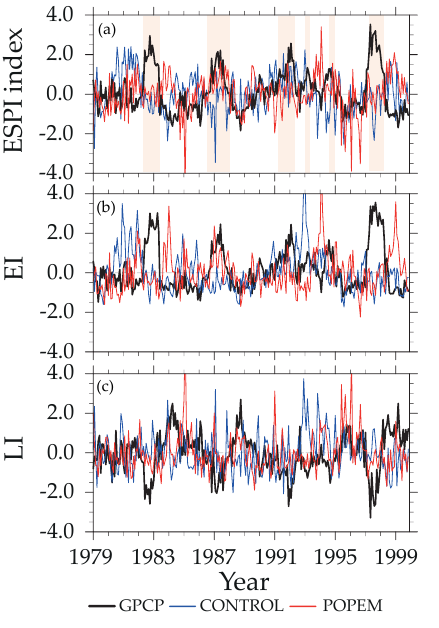
Figure 13. Time series of precipitation anomalies for the ENSO region after Curtis and Adler (2000). (a) ENSO precipitation in- dex (ESPI), (b) El Niño Index (EI), and (c) La Niña Index (LI). The Black line shows GPCP data, the blue line is the CONTROL case, and the red line is the POPEM case. Orange shading denotes El Niño years defined as consecutive months (minimum 3) with NIÑO3.4 SST anomalies (5 ◦ N–5 ◦ S, 170–120 ◦ W) greater than + 0 . 5 ◦